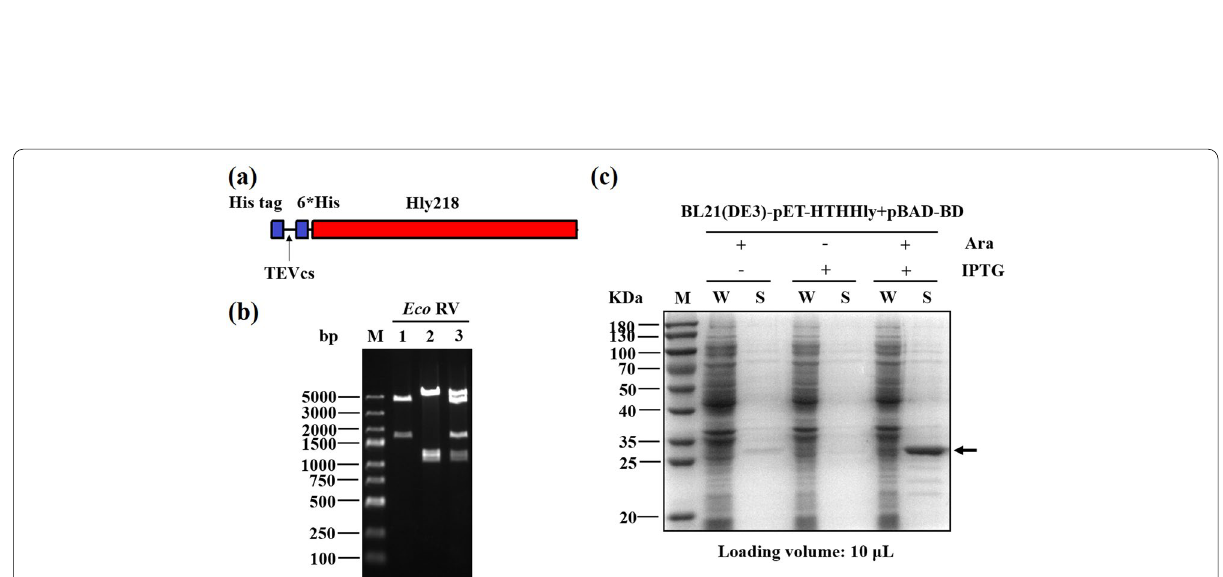
Fig. 2 Secretory expression of HTHHly. a Plasmid pET-HTHHly. b Verification of the expression strain harboring the two plasmids. Lane 1: plasmid pET-HTHHly; Lane 2: plasmid pBAD-BD; Lane 3: plasmid extracted from